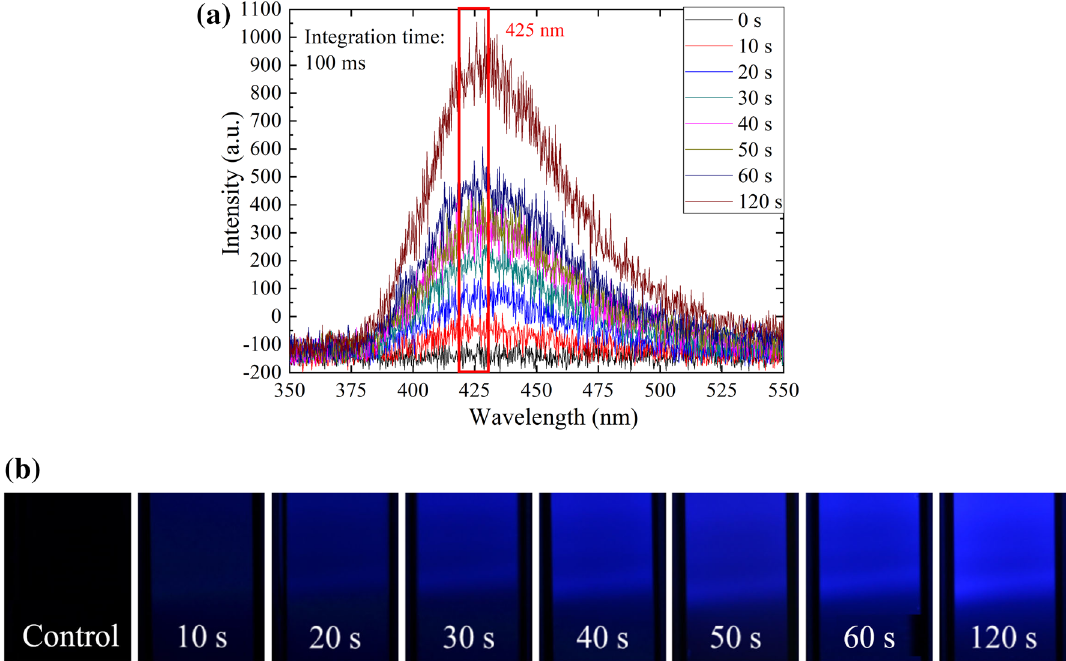
Figure 3. RPMI medium was exposed to NTAPPJ for various time periods. The fluorescent intensity of HTA was measured using an OES ( a ), with images taken using a CCD camera ( b